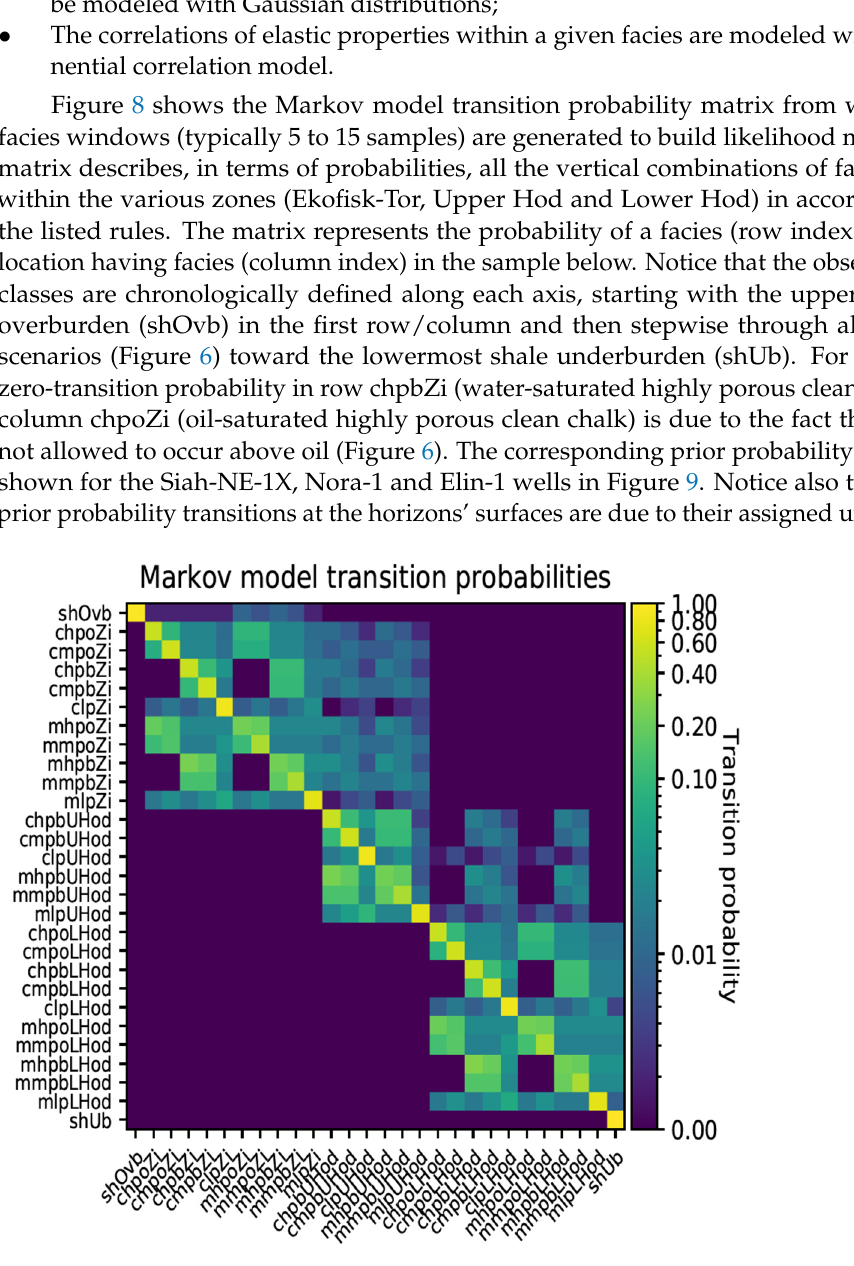
Figure 8. Markov model transition probability matrix. Probabilities are given in volume fractions ( v / v ); shOvb and shUb are shale overburden and underburden, respectively. The information in the matrix is used locally when generating facies windows for generating likelihood models.